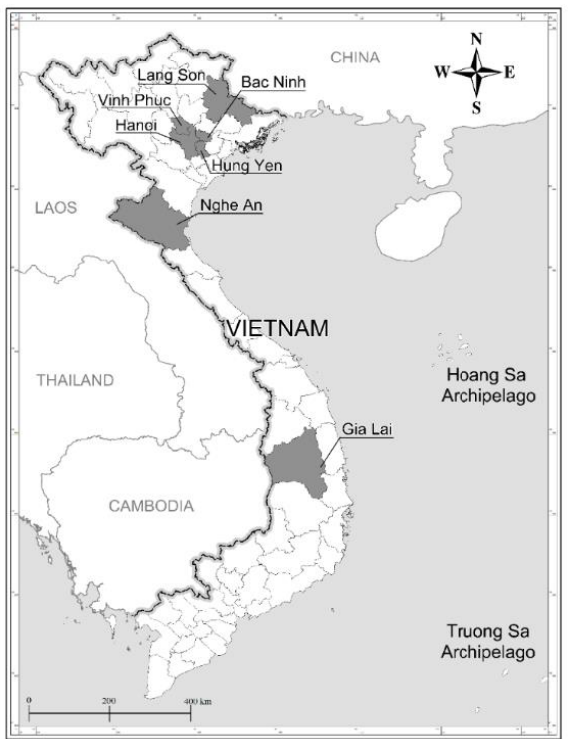
Figure 1. Map of Vietnam with the provinces where Dalbergia tonkinensis mother trees were located and seeds were collected.